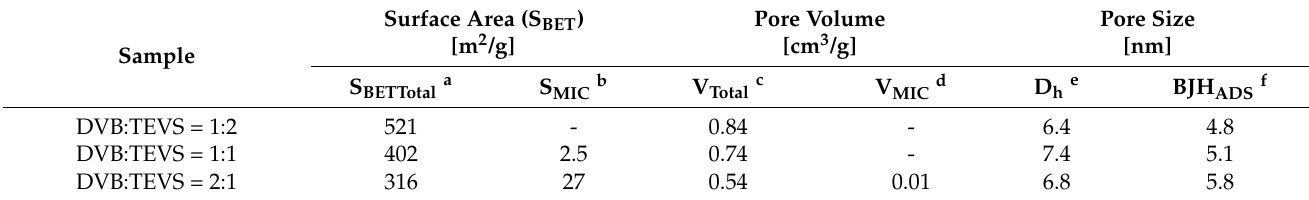
Table 2. The values of parameters characterizing the porous structure of DVB-TEVS.